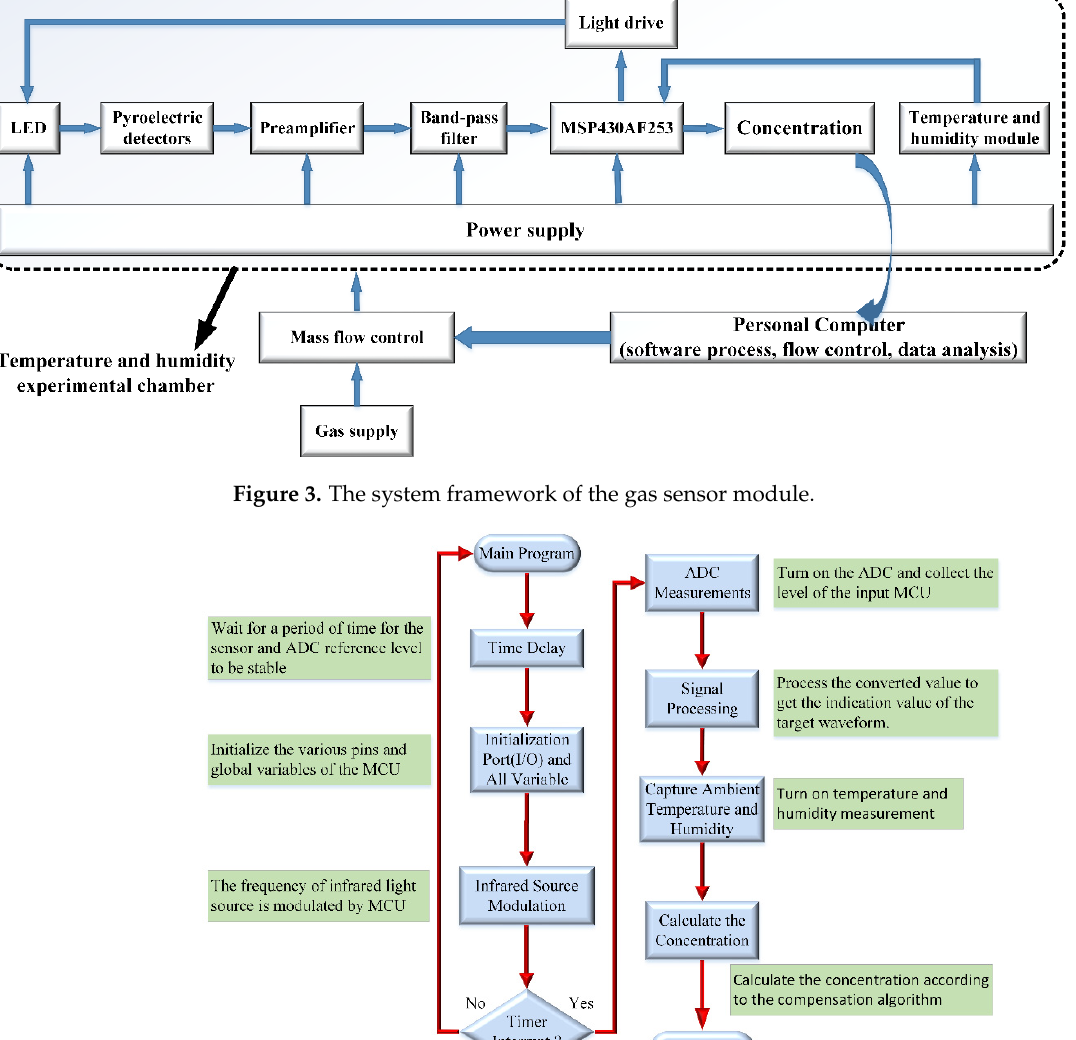
Figure 4. Flowchart of the program design of the sensor module.